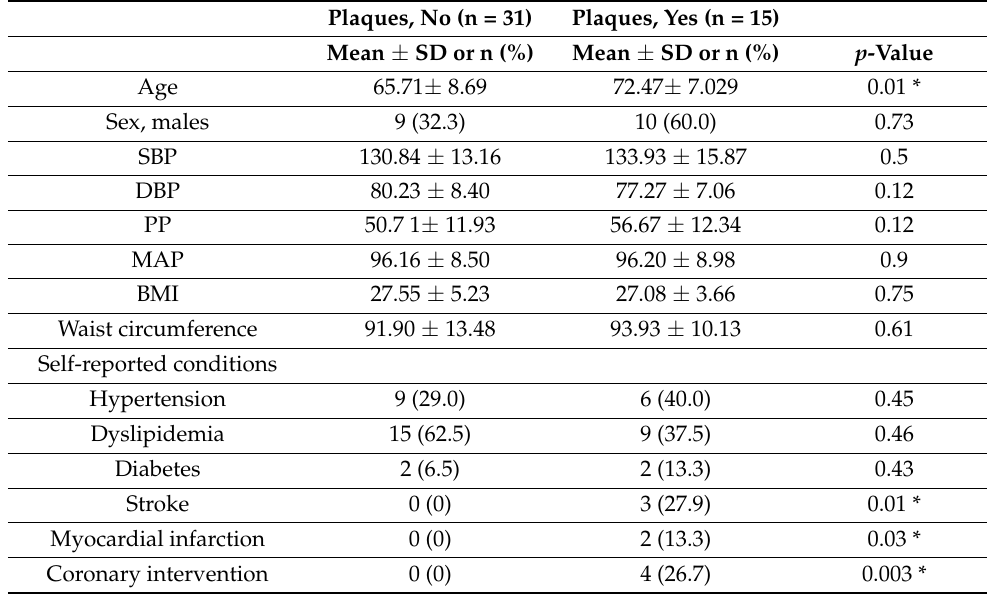
Table 3. Cardiovascular risk factors among subjects with and without carotid